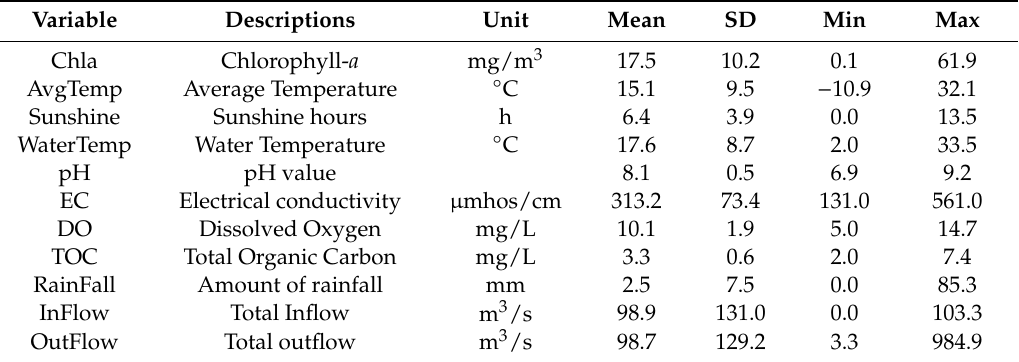
Table 1. Characteristics of the response and explanatory variables measured in the Nakdong